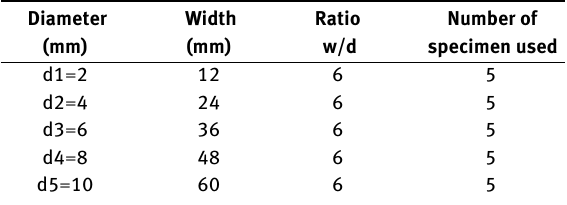
Table 2. Experimental matrix program.